Question: Write the caption for this figure.
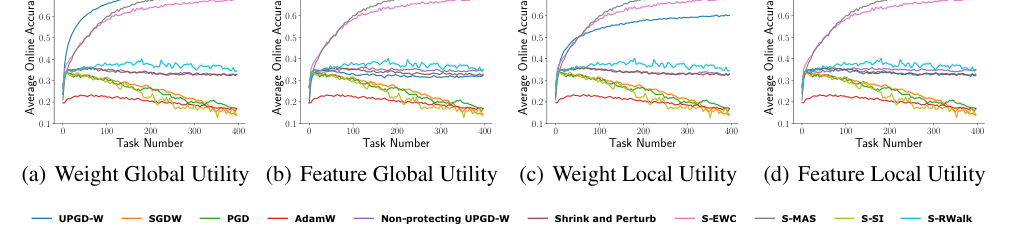
Answer: Performance of methods on Label-permuted EMNIST. First-order utility traces are used for UPGD and Non-protecting UPGD. Results are averaged over 10 runs.